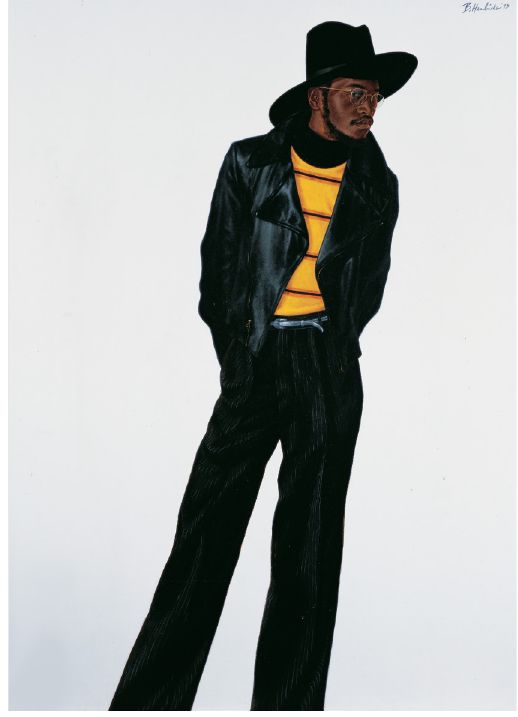
Figure 14. Hendricks, Barkley L., New Orleans Niggah (1973). Oil and acrylic on cotton canvas, 72 x 52 in. ©Estate of Barkley L. Hendricks. Courtesy of Jack Shainman Gallery, New